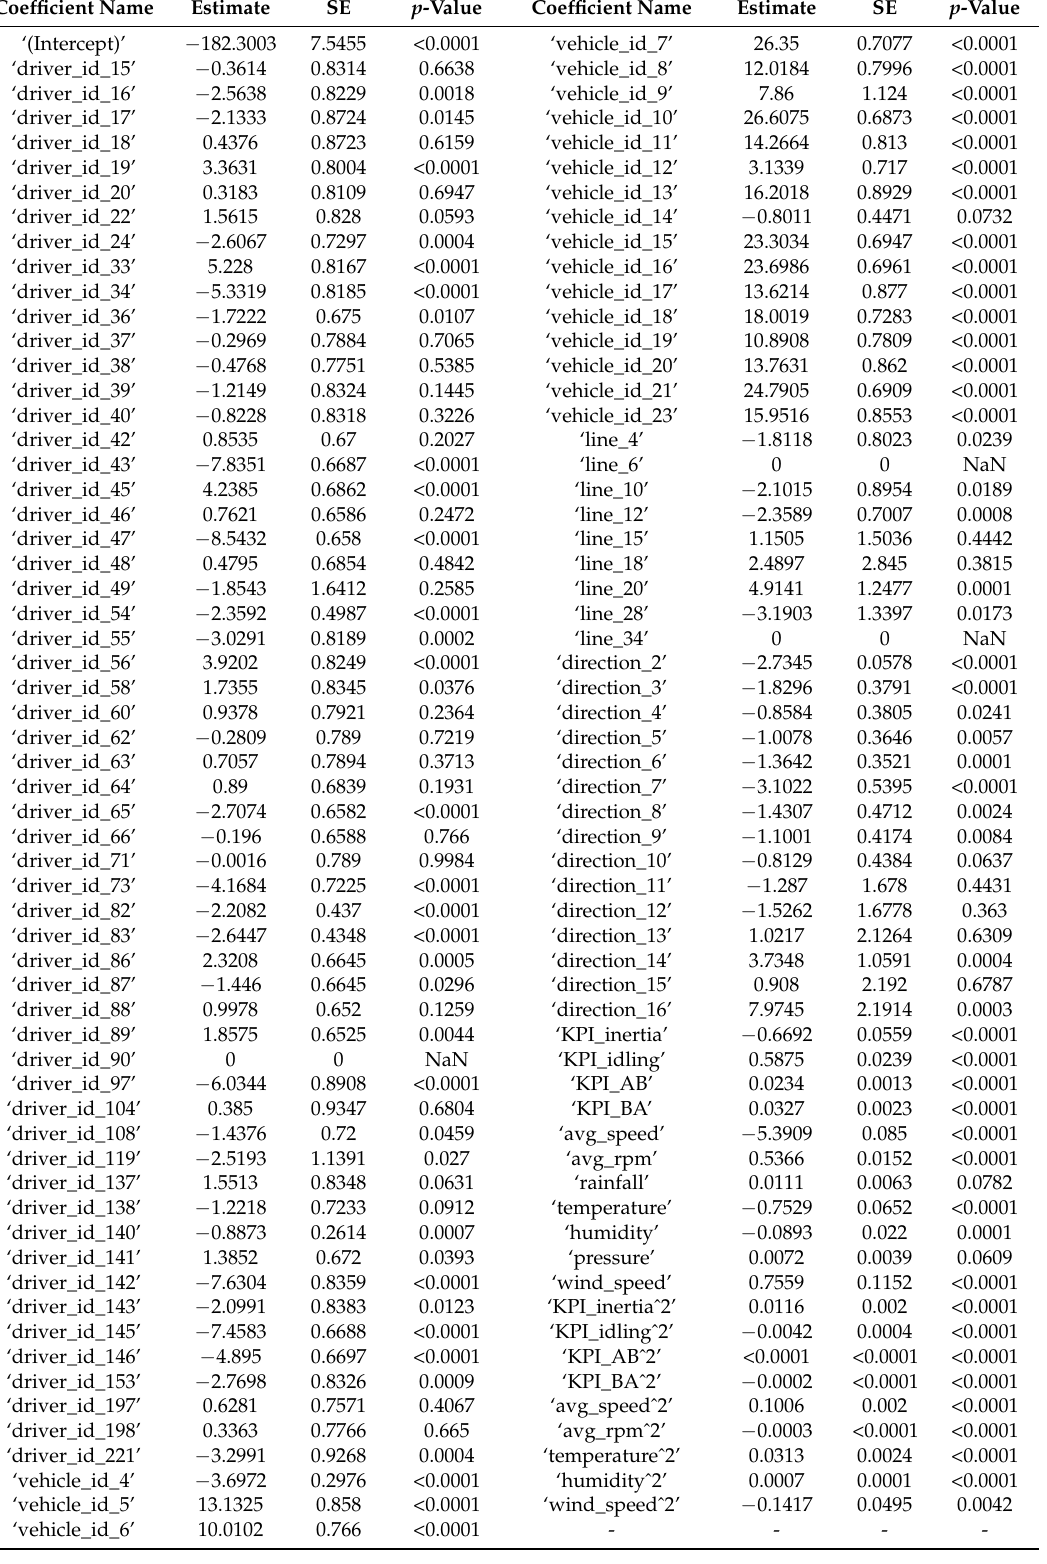
Table A2. Coefficient estimation for the simplified quadratic